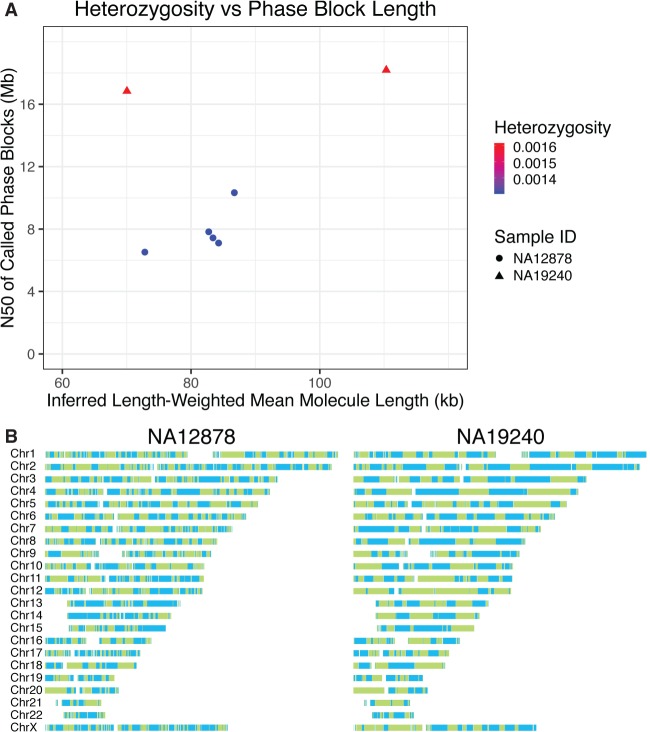
Haplotype reconstruction and phasing. (A) Inferred length-weighted mean molecule length plotted against N50 of called Phase blocks (both metrics reported by Long Ranger) and differentiated by sample ID and heterozygosity. Heterozygosity was calculated by dividing the total number of heterozygous positions called by Long Ranger by the total number of non-N bases in the reference genome (GRCh37). Two replicates of NA19240 and five replicates of NA12878 were used. Samples with higher heterozygosity produce longer phase blocks than samples with less diversity when controlling for input molecule length. (B) Phase block distributions across the genome for input length matched Chromium Genome samples NA12878 and NA19240. Phase blocks are shown as displayed in Loupe Genome Browser. Solid colors indicate phase blocks. Note the longer phase blocks in the more diverse NA19240 sample.